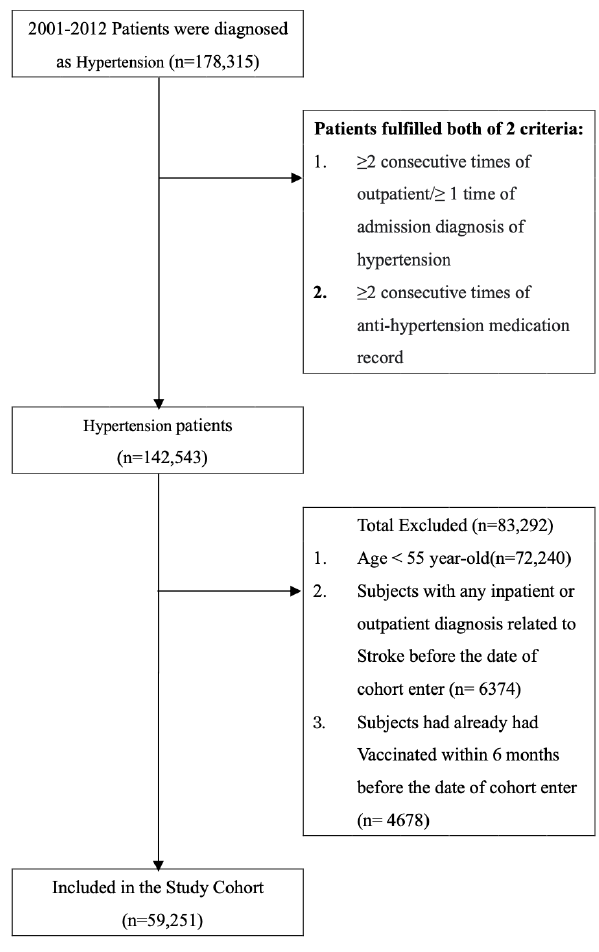
Figure 1. Data selection process. Table 1. Characteristics of the Sample Population.